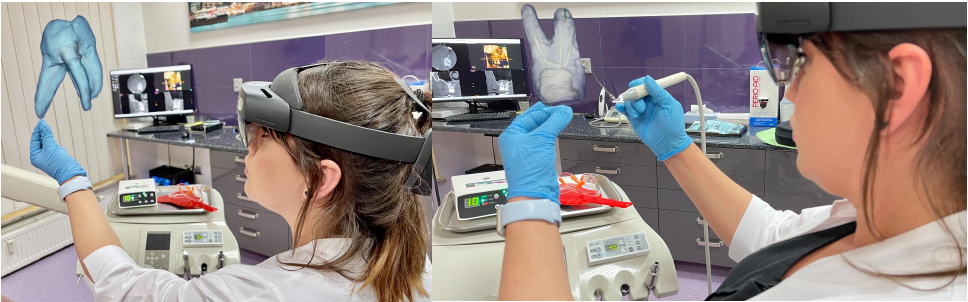
Figure 3. The scheme of the MR-based supporting system for root canal treatment.